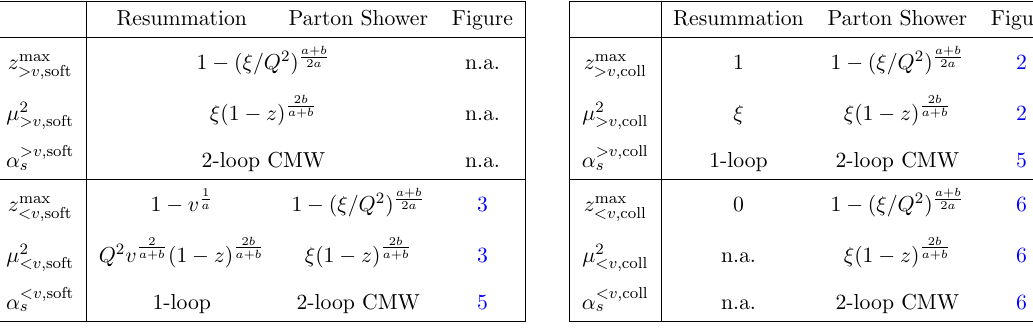
Table 1 . Choices of parameters in eq. (2.15) leading to eq. (2.13) (NLL resummation) and eq. (2.12) (parton shower). The e(cid:11)ects of switching between the two parametrizations are investigated in the (cid:12)gure referred to in the last column. More details can be found in section